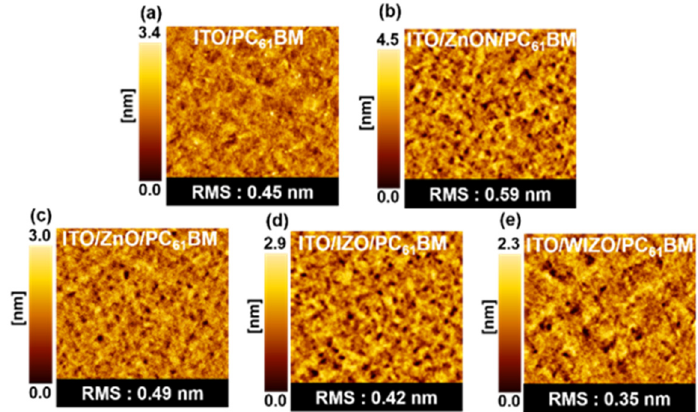
Figure 3. Topographic images (size: 5 µ m × 5 µ m) of ( a ) ITO / PC 61 BM, ( b ) ITO / ZnO / PC 61 BM, ( c ) ITO / ZnON / PC 61 BM, ( d ) ITO / IZO / PC 61 BM, and ( e ) ITO / WIZO / PC 61 BM films.